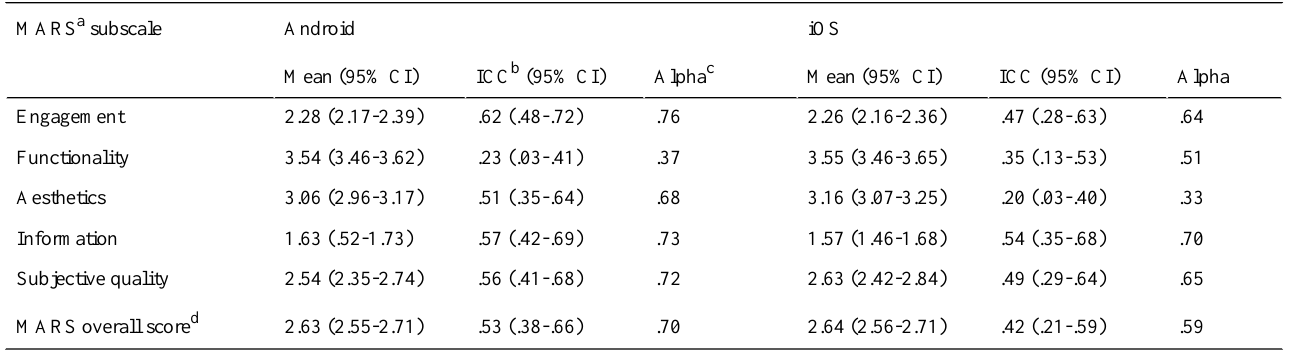
Table 2. Mobile App Rating Scale scores.